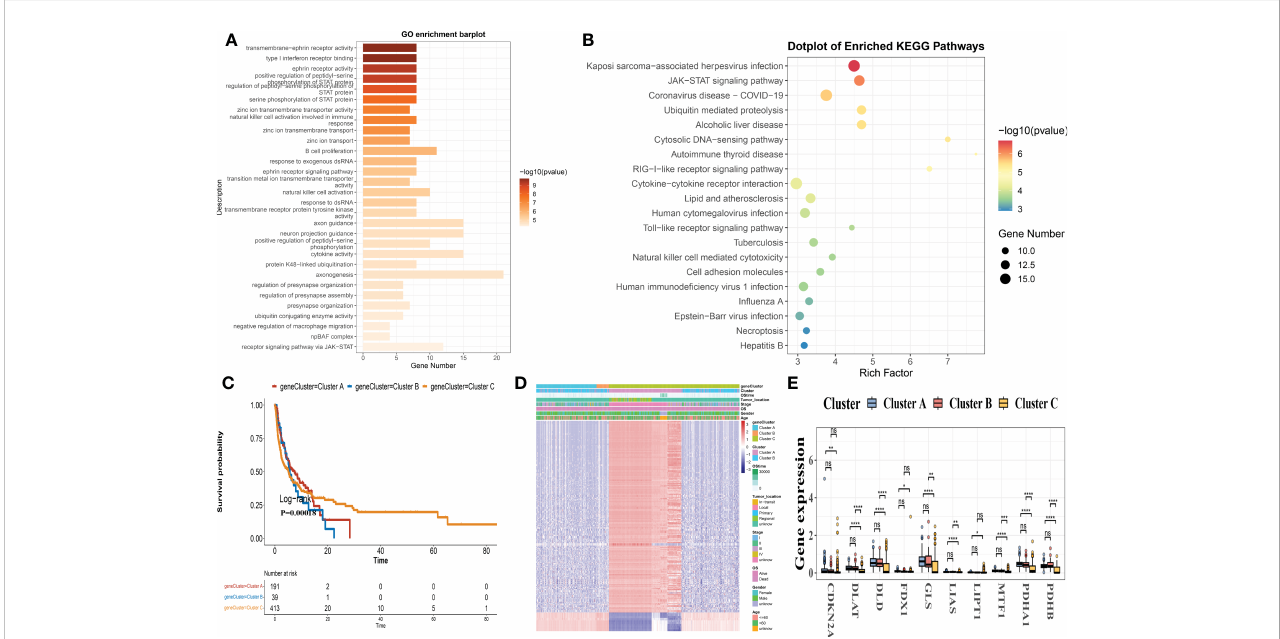
FIGURE 5 DEGs are used to identify gene subgroups. (A, B) GO and KEGG enrichment analyses of DEGs in two cuprotosis subgroups. (C) Kaplan-Meier curves for the two gene subgroups ’ overall survival (log-rank tests, p< 0.001). (D) Associations between clinicopathologic characteristics and the two gene subgroups. (E) Expression differences in ten CRGs between the two gene subgroups. DEGs, differentially expressed genes; GO, Gene Ontology; KEGG, Kyoto Encyclopedia of Genes and Genomes; CRGs, Cuprotosis-related